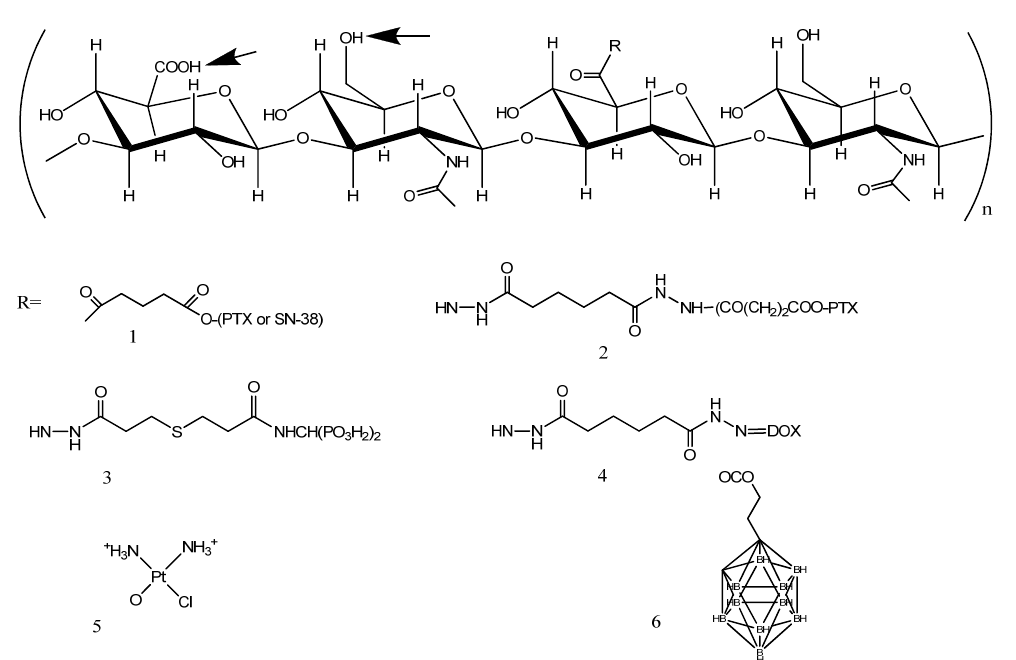
Figure 1. Hyaluronic acid and small molecule